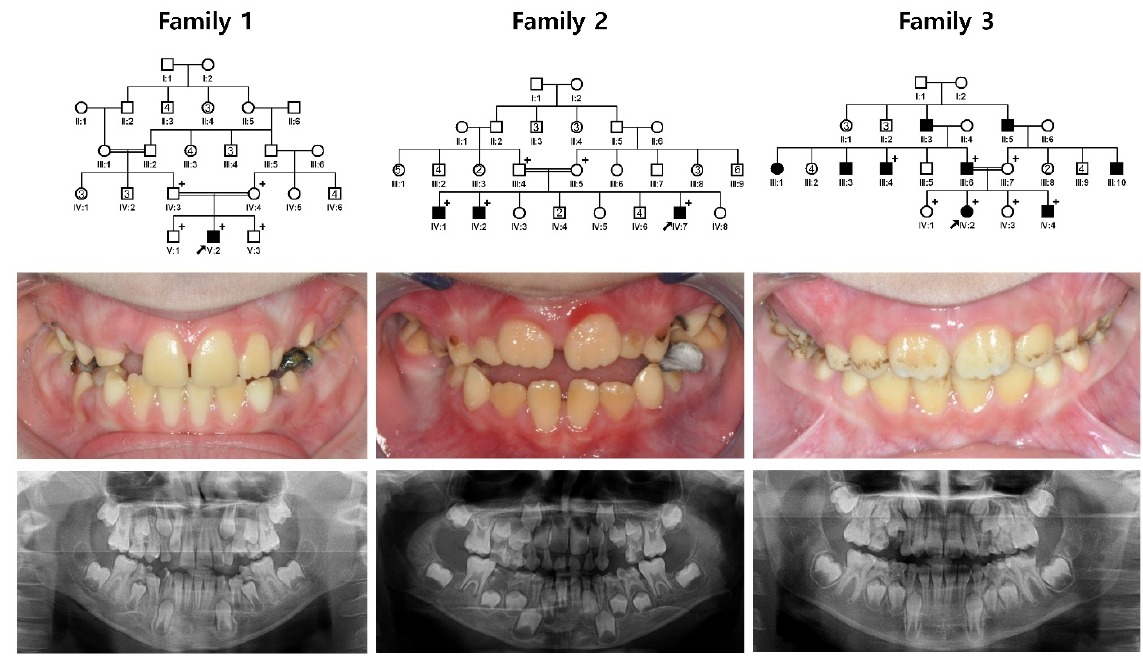
Figure 1. Family pedigrees, frontal clinical photos and panoramic radiographs. Clinical images and panoramic radiographs show generalized hypomaturation AI with yellow-brown discoloration. Some teeth of the proband in family 3 had external staining. Plus (+) symbols indicate individuals who participated in this study, and a black arrow identifies the proband in each family. Numbers in the symbol indicate the number of siblings.